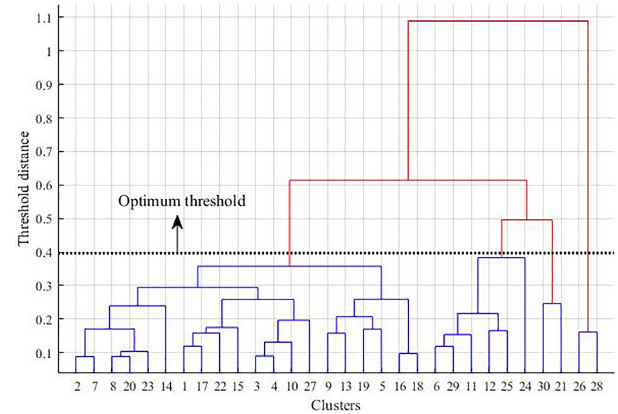
Figure 3. Dendrogram for identifying the optimum threshold and number of